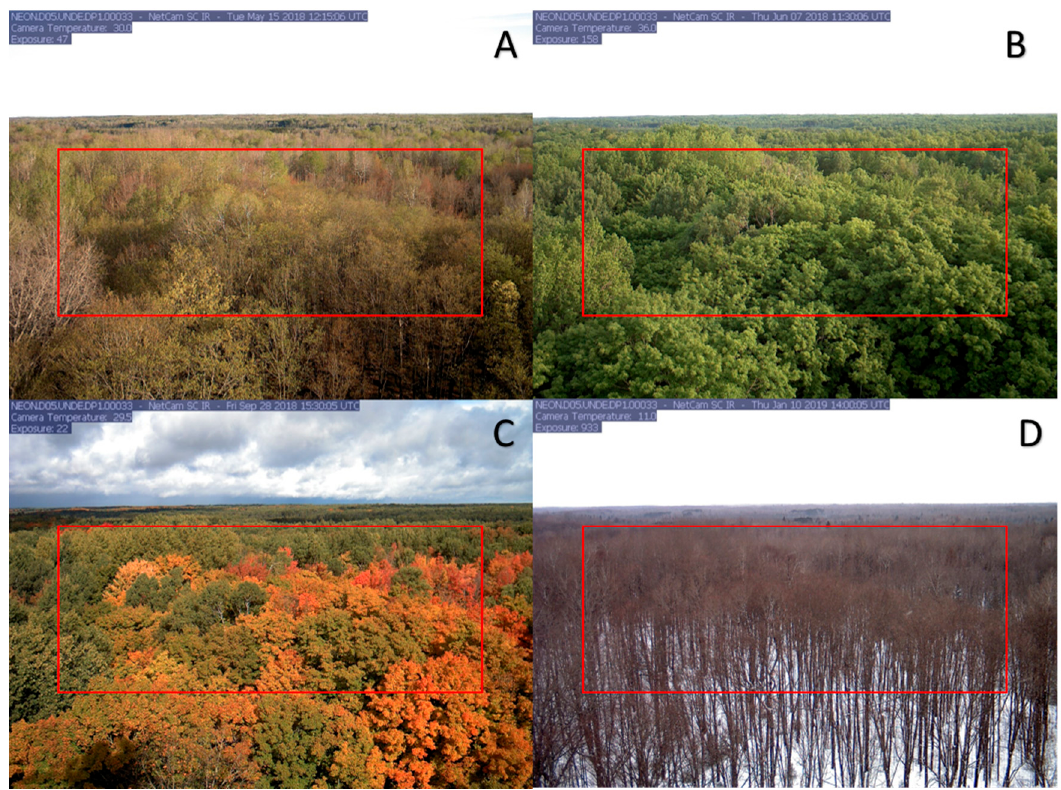
Figure 2. PhenoCam images captured in ( A ) spring, ( B ) summer, ( C ) autumn and ( D ) winter over the NEON.D05.UNDE.DP1.00033 site (46.23°N, 89.54°W). The red rectangle indicates the borders of the selected region of interest.